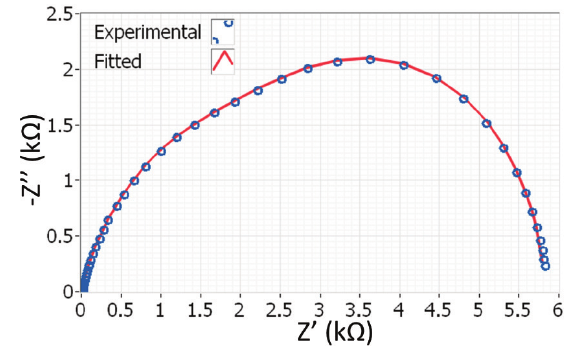
Figure 8. Impedance spectra under the open circuit condition (0.51 V). Fitting was achieved using the model shown in Figure 1 with an extracted diffusion length of 15.1 µ